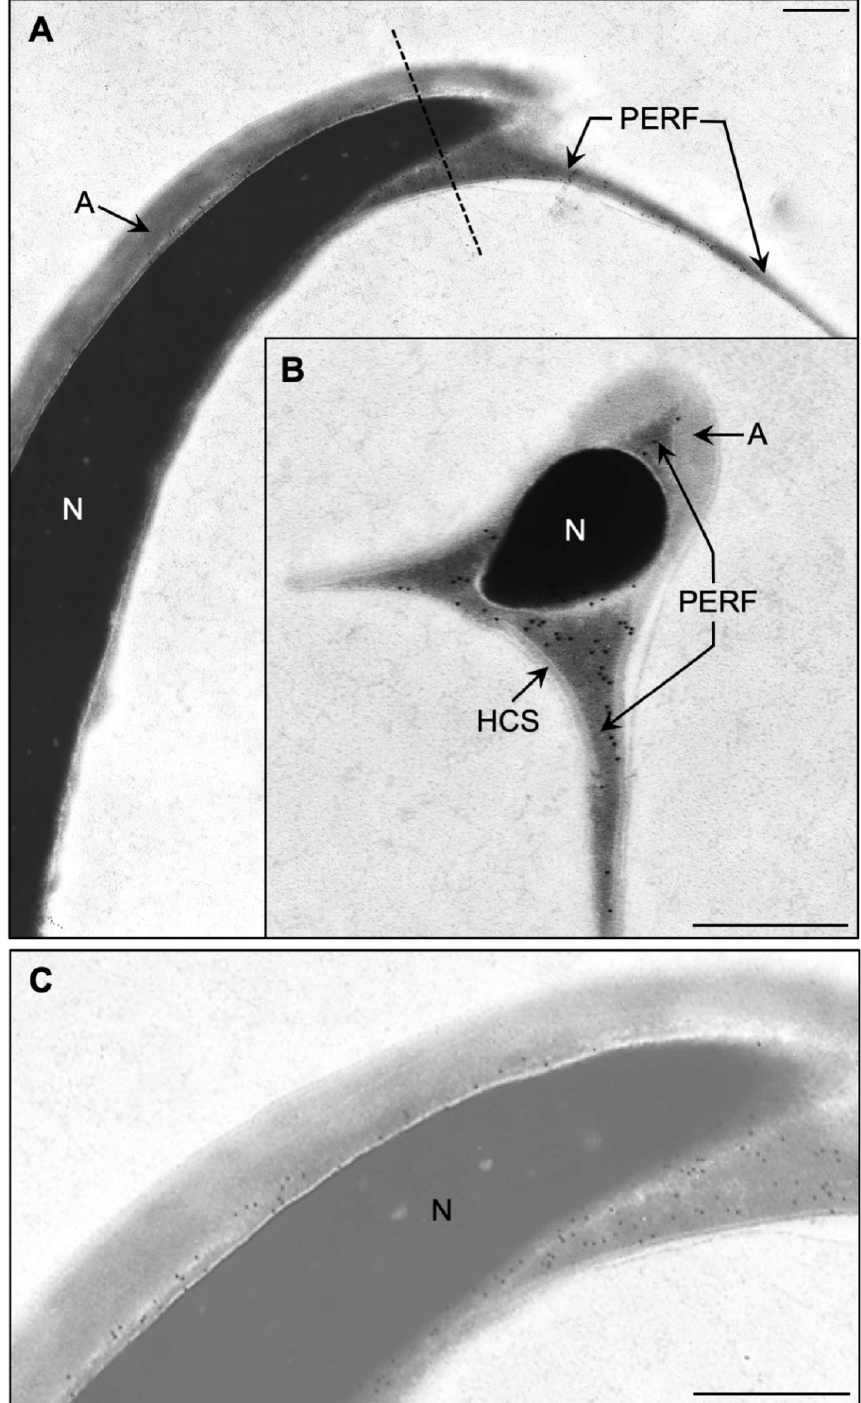
Figure 3. Transmission electron microscopy showing the presence of histones in the PT of cauda epididymal rat sperm: ( A ) A sagittal section through the sperm head labeled with an affinity purified anti-H3 antibody; ( B ) a coronal or cross section through the apical perforatorial region (in the area shown by the dashed line in (A) labeled with anti-H3 antibody (note that all three prongs of the perforatorium are immunogold-labeled); ( C ) reduced exposure of negative to show that the nucleus in contrast to the PT is not immunoreactive to the anti-histone antibody. Labels: A, acrosome; N, nucleus; PERF, perforatorium; HCS, displaced head cap segment. Bars = 1 μ m.